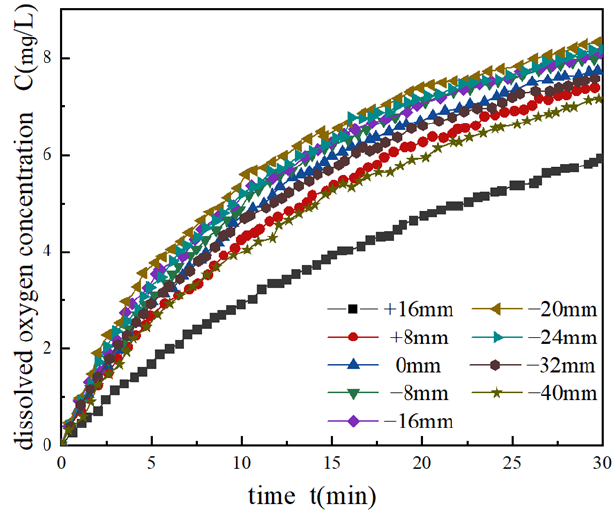
Figure 8. The dissolved oxygen concentrations at different immersion depths.